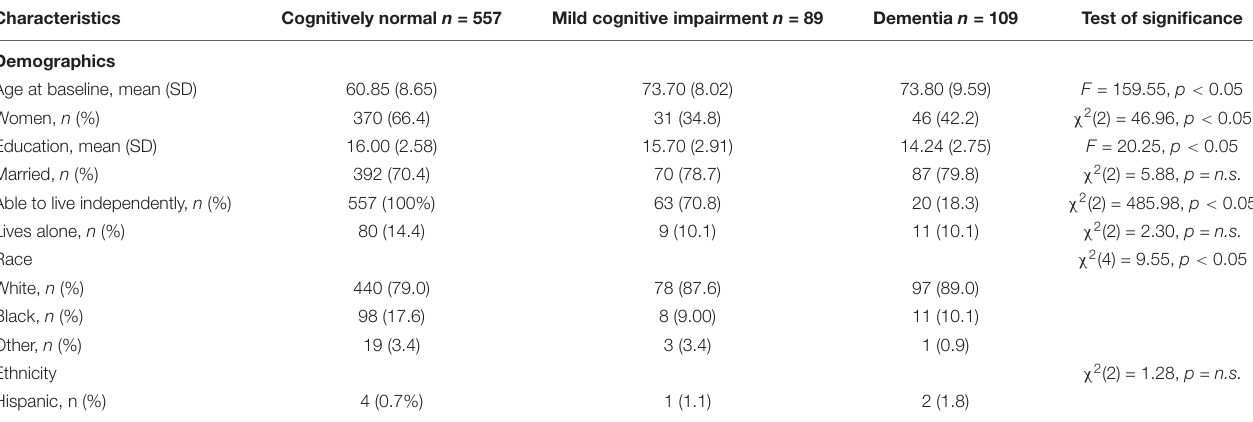
TABLE 1 | Baseline characteristics of participants.